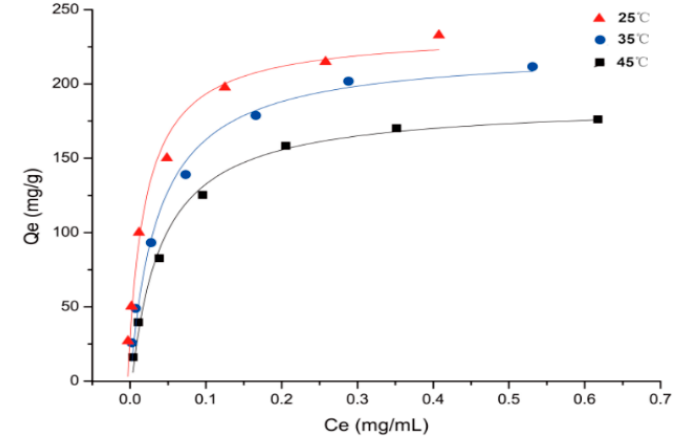
Figure 2. Adsorption isotherms of total PMFs on HPD 300 resin at 25, 35, and 45 °C. Table 4. Langmuir and Freundlich parameters of PMFs on HPD 300 resin at different temperatures.